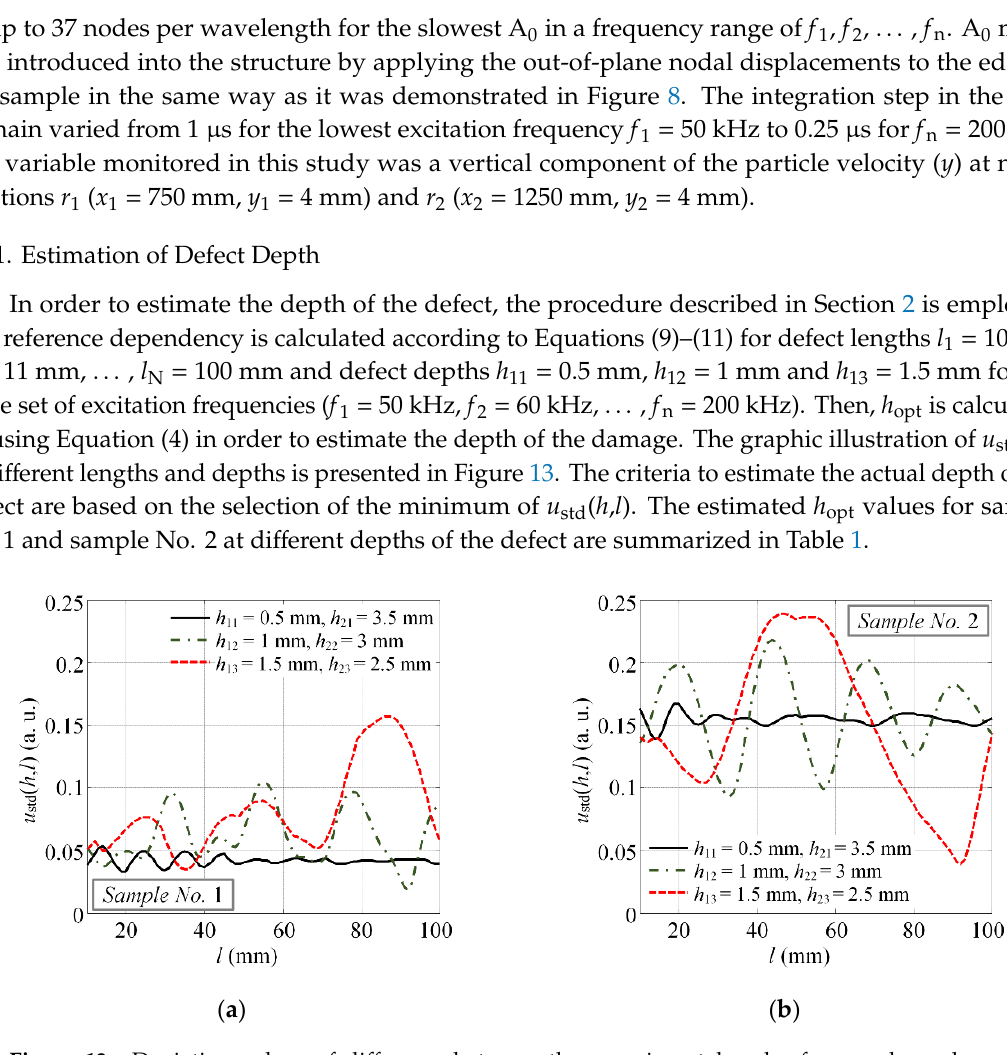
14 of 19 Figure 12. Graphic representation of investigated cases: sample No. 1 with 70 mm wide delamination located 1 mm below the surface ( a ), sample No. 2 with delamination of 90 mm at depth of 1.5 mm ( b ). 4.1.1. Estimation of Defect Depth In order to estimate the depth of the defect, the procedure described in Section 2 is employed. The reference dependency is calculated according to Equations (9)–(11) for defect lengths l 1 = 10 mm, l 2 = 11 mm, …, l N = 100 mm and defect depths h 11 = 0.5 mm, h 12 = 1 mm and h 13 = 1.5 mm for the same set of excitation frequencies ( f 1 = 50 kHz, f 2 = 60 kHz, …, f n = 200 kHz). Then, h opt is calculated by using Equation (4) in order to estimate the depth of the damage. The graphic illustration of u std ( h , l ) at different lengths and depths is presented in Figure 13. The criteria to estimate the actual depth of the defect are based on the selection of the minimum of u std ( h , l ). The estimated h opt values for sample No. 1 and sample No. 2 at different depths of the defect are summarized in Table 1. Table 1. h opt values for sample No. 1 and sample No. 2 which are used as a criterion to estimate the depth of delamination.